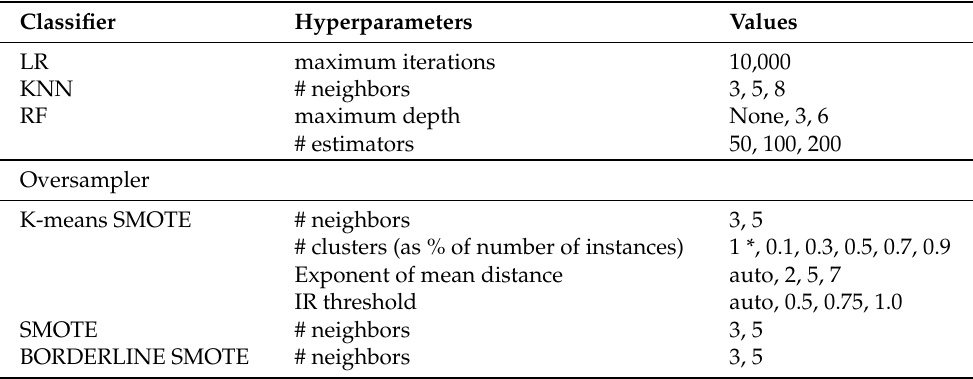
Table 2. Hyper-parameters grid. * One cluster is generated in total, a corner case that mimics the behavior of